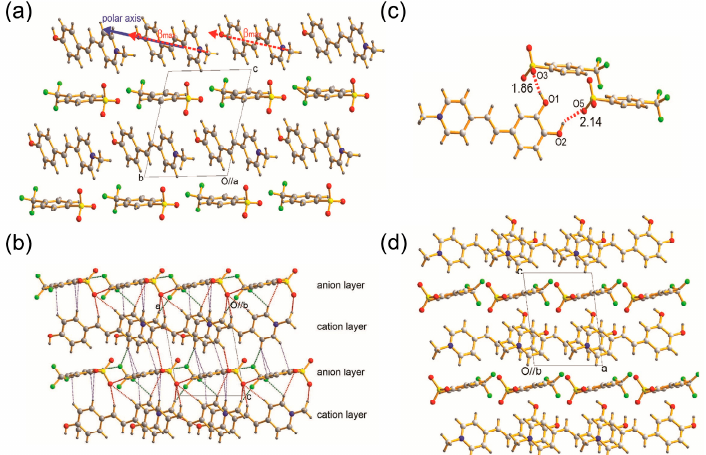
Figure 2. Chemical structures of pyridinium-based OHP-TFS and DHP-TFS. In order to reduce the vibrational amplitude in the crystal, the TFS anion with strongly electronegative -CF 3 is introduced to increase the interaction and reduce the void volume (or increase the density), which can form strong hydrogen bonding interactions between phenolic groups on cations [27]. In OHP-TFS crystal, the OHP cations are perfectly aligned in parallel, as shown as Figure 3a,b, which leads to maximizing the value of the diagonal effective hyperpolarizability tensor to a level equivalent to that of DAST, indicating that OHP-TFS would also exhibit a strong SHG intensity [28]. As shown in Figure 3c, the catechol group causes DHP cations and TFS anions to form two strong hydrogen bonds, with distances of 1.86 Å and 2.14 Å, respectively. The DHP-TFS crystal exhibits a parallel-type cation-anion assembly (Figure 3d), which is similar to the classic DAST, and the average value of (I DHP-TFS /I DAST ) 0.5 is ≈ 0.7 under the fundamental light ≥ 1500 nm [33].